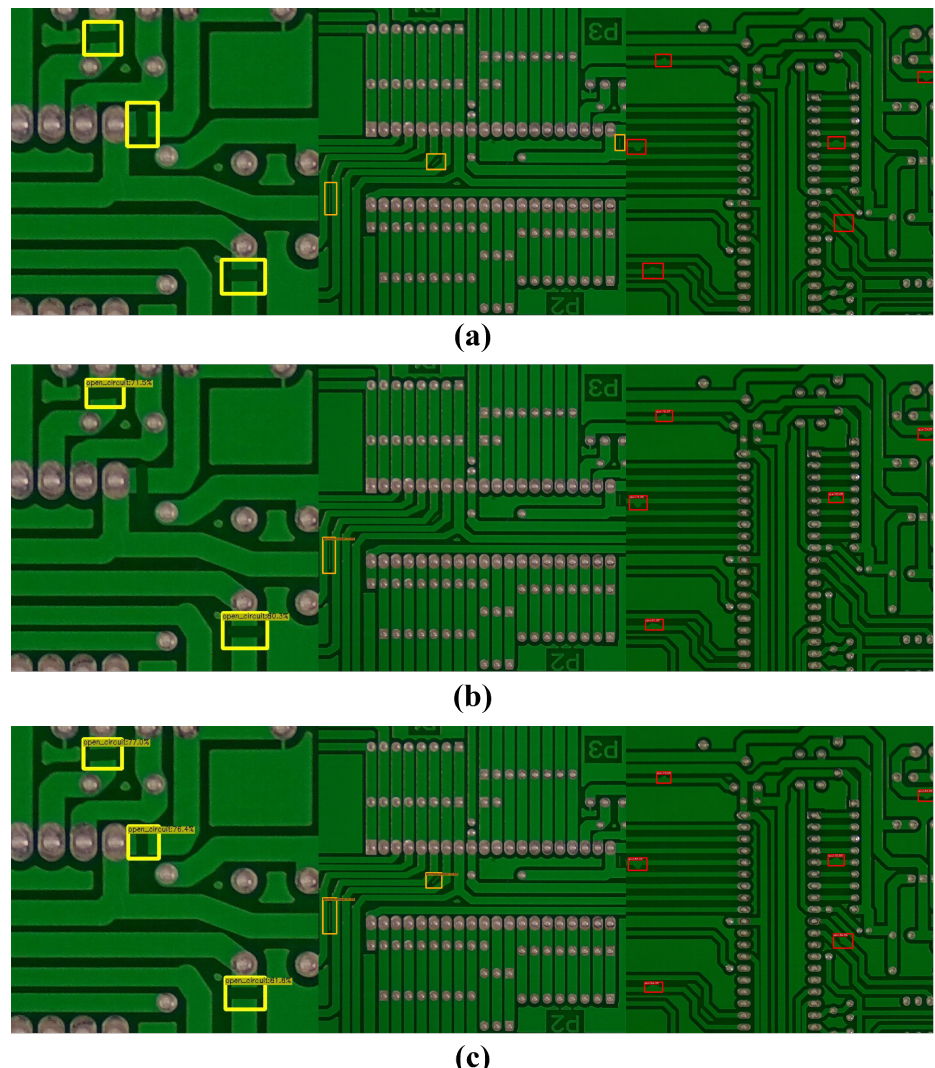
Figure 9. The PCB dataset results. ( a ) Ground truth of the dataset. ( b ) Baseline prediction label. ( c ) Model prediction label of this